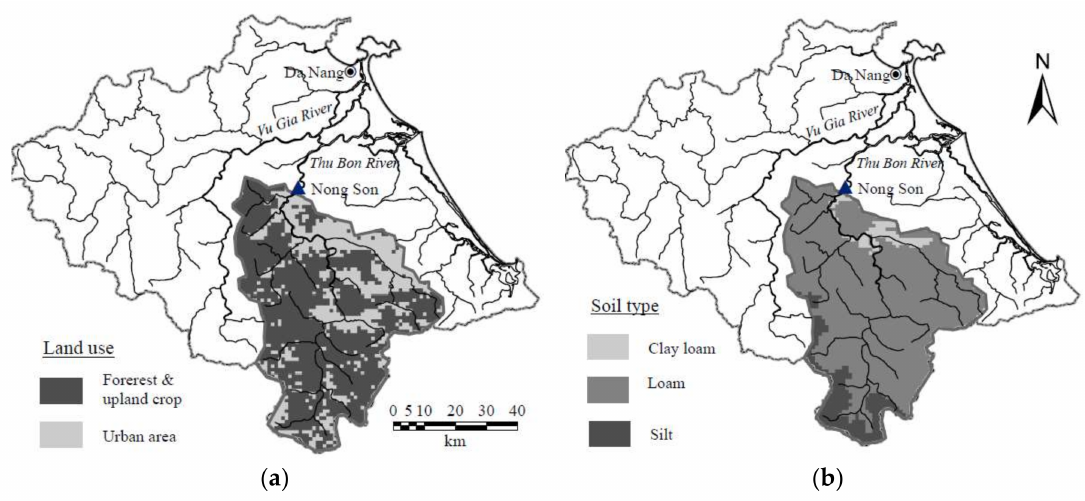
Figure 3. Distribution of ( a ) land use and ( b ) soil type in the upper Thu Bon River